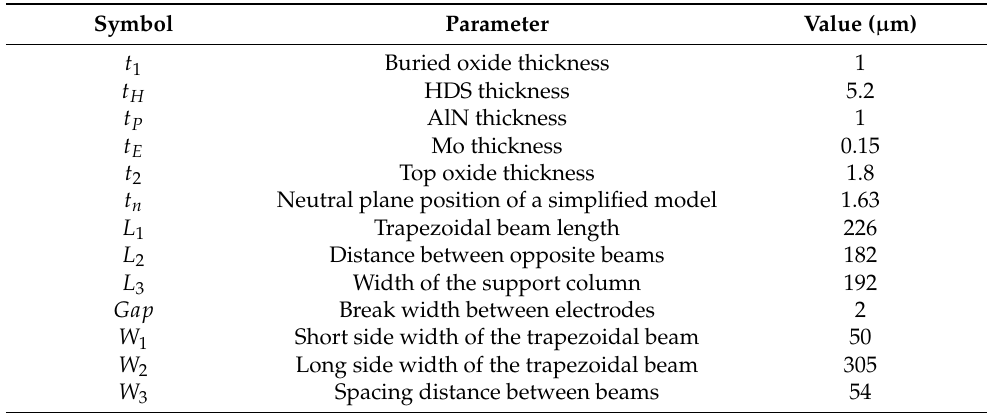
Figure 1. ( a ) Three ‐ dimensional view, ( b ) front view, and ( c ) cross ‐ sectional view of the designed miniaturized piezoelectric MEMS accelerometer with polygonal topology. Table 1. Specific structural dimensions of Type A